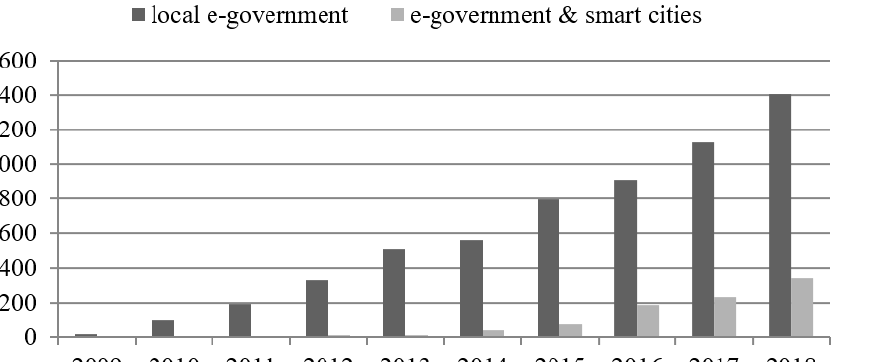
Figure 3. Evolution of the number of citations received by documents addressing local e-government (excluding smart cities) and by documents addressing smart cities in the context of e-government, published between 2009 and 2018, as retrieved from the Scopus database